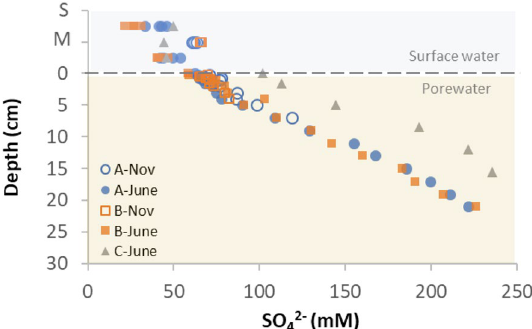
Figure 2. Sulphate concentration in surface and pore water. The water column depths ranged from 30 to 60 cm depending on the season and sampling point. In the plot, “ S ” = surface and “ M ” = middle. Deeper cores were obtained in June 2021 compared to November